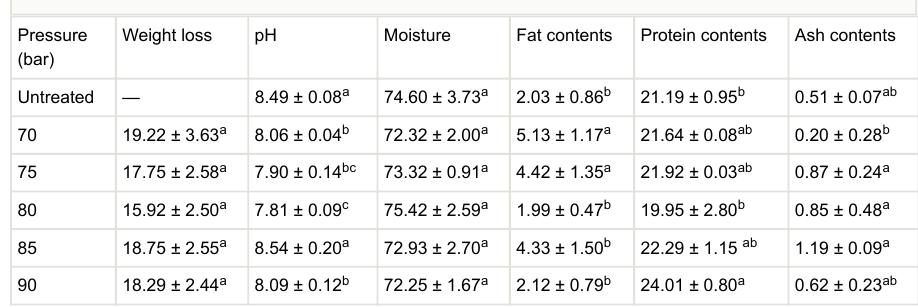
Effect of CO pressure at 40 °C on proximate values of fillet and its post-pressurization pH.